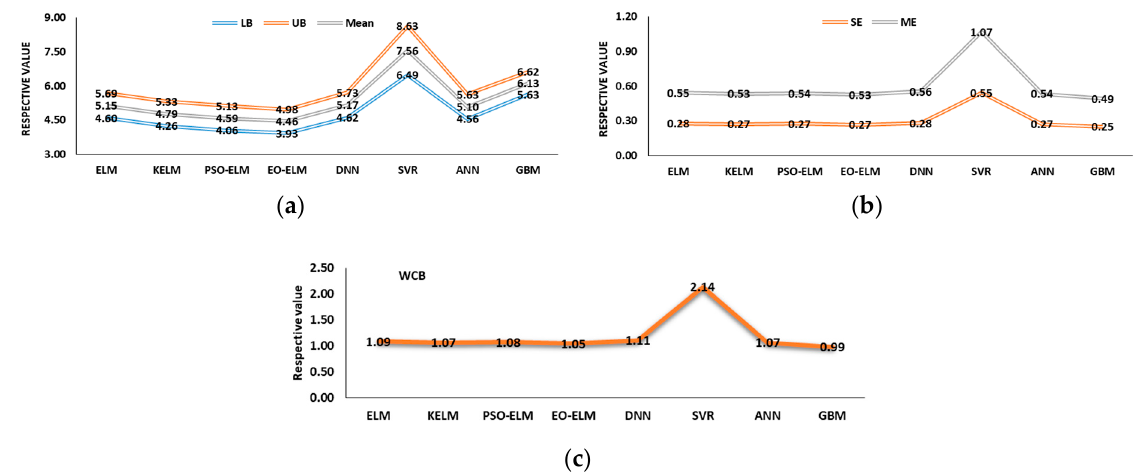
Figure 21. Visual representation of uncertainty analysis (UA) for lag-based models (Teifi at Glanteifi), ( a ) LB, UB and Mean; ( b ) SE and ME; ( c ) width of confidence (WCB).